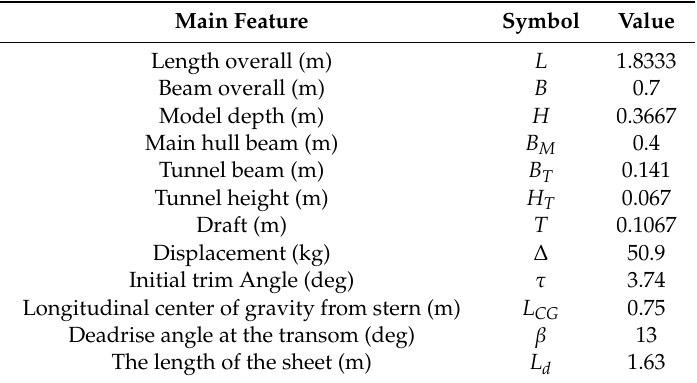
Table 1. Main dimensions of the planing